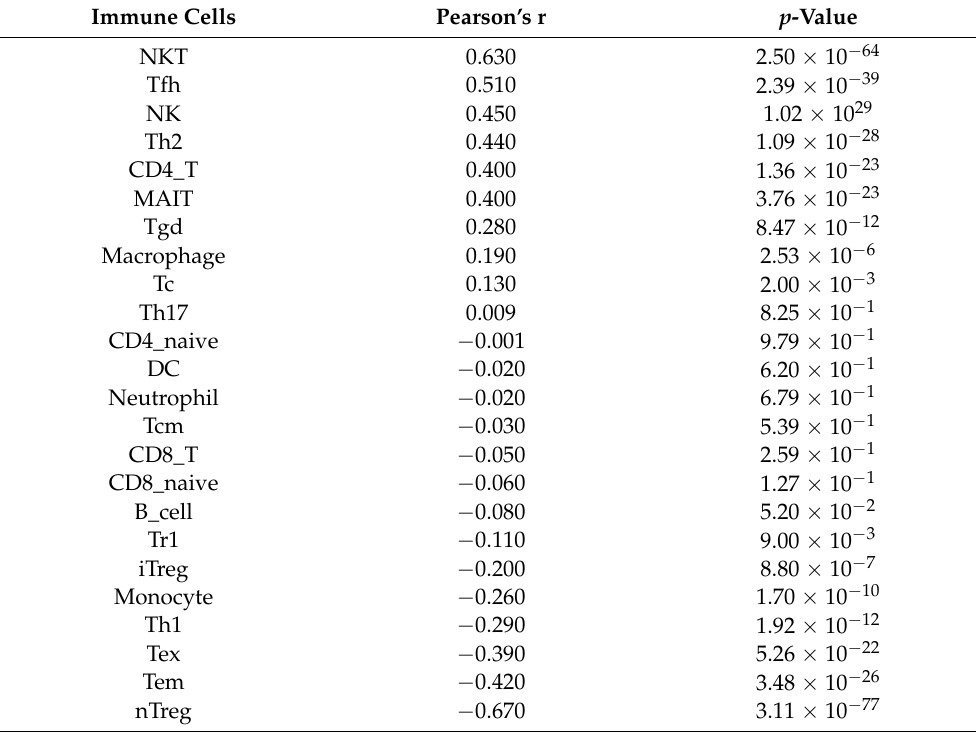
Table 3. TCGA LUAD immune cell correlations with ADAMTS8. Immune